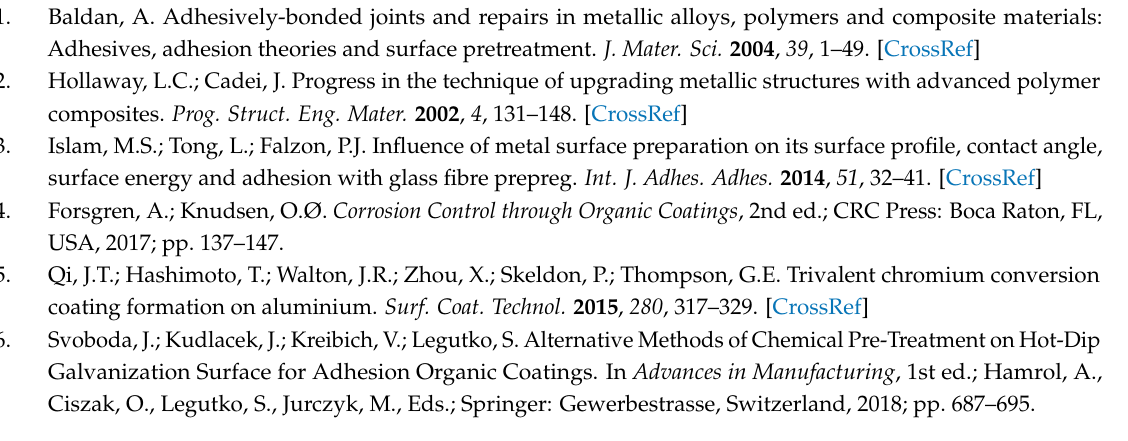
Supplementary Materials: The following are available online, Figure S1: Schematic diagram showing pseudo-transesterification of the α -alumina particulates with methyl methacrylate (MMA) (* PTSA: p -toluenesulfonic acid), Figure S2: Differential pulse voltammetry of different alumina colloid suspensions in 0.1 M NaOH. Colloid M1: 150 ppm of Al 2 O 3 particles; Colloid M2: 150 ppm of Al 2 O 3 particles after being immersed in a solution of MMA monomer and washed with methanol; Colloid M3: 150, 450 and 950 ppm of Al 2 O 3 particles with pseudo-transesterification treatment, Figure S3: Viability of Pesudomonas aeruginosa incubated on ( a ) AA2024, ( b ) AA2024 + PMMA and ( c ) AA2024 + TE + PMMA-AgNPs 0.01